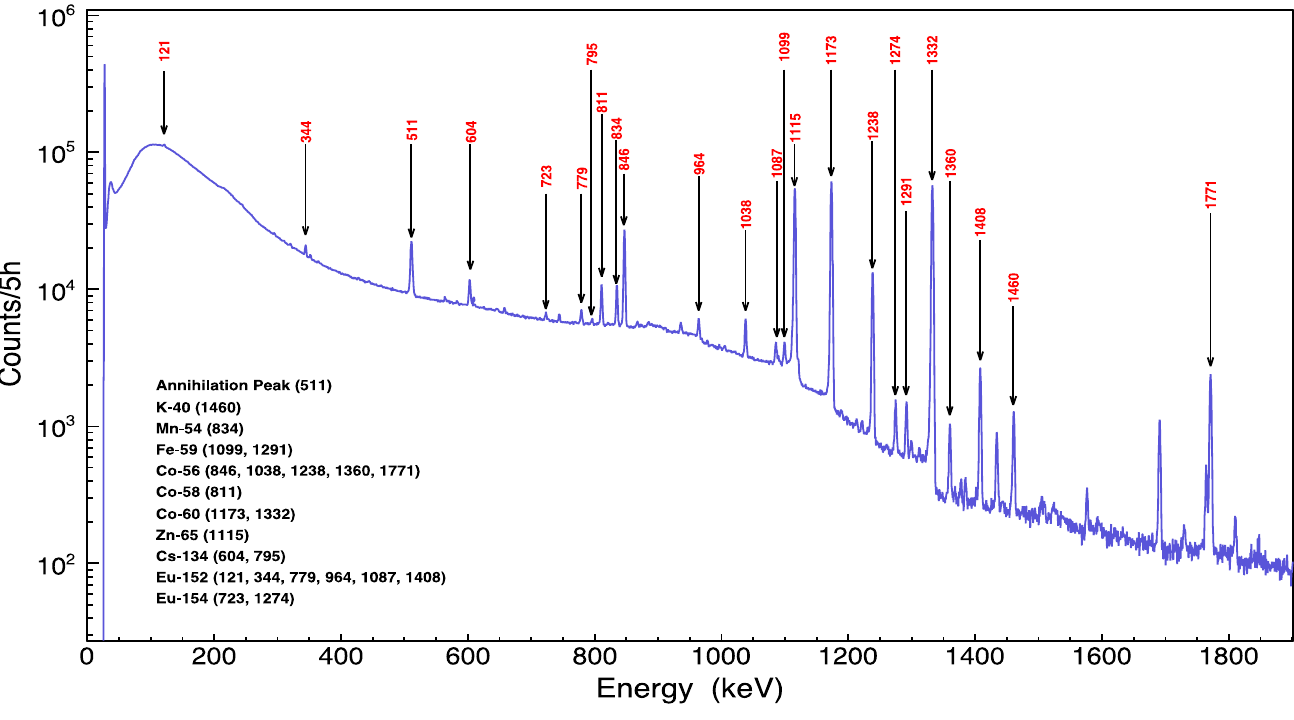
Figure 4. Gamma-ray spectrum of the CS-30 cyclotron vault wall 4.